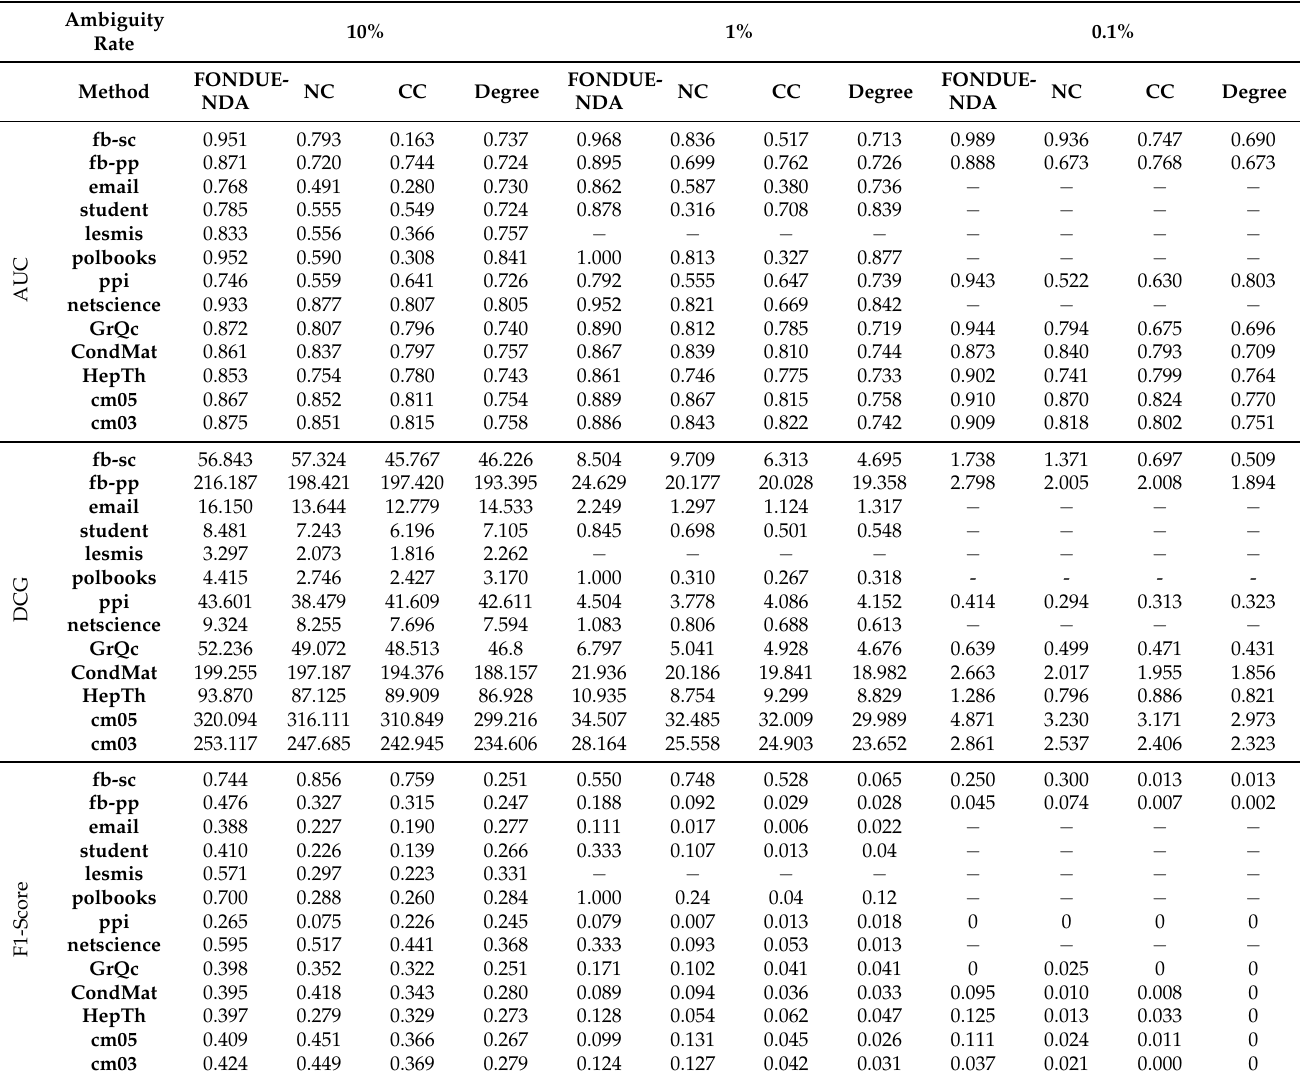
Table A1. Performance evaluation for AUC score, DCG and F1-score on multiple datasets for our FONDUE-NDA compared with other baselines. Note that for some datasets with a small number of nodes, we did not perform any contraction for 0.001 as the number of contracted nodes in this case is very small, thus we replaced the values for those methods by “ −